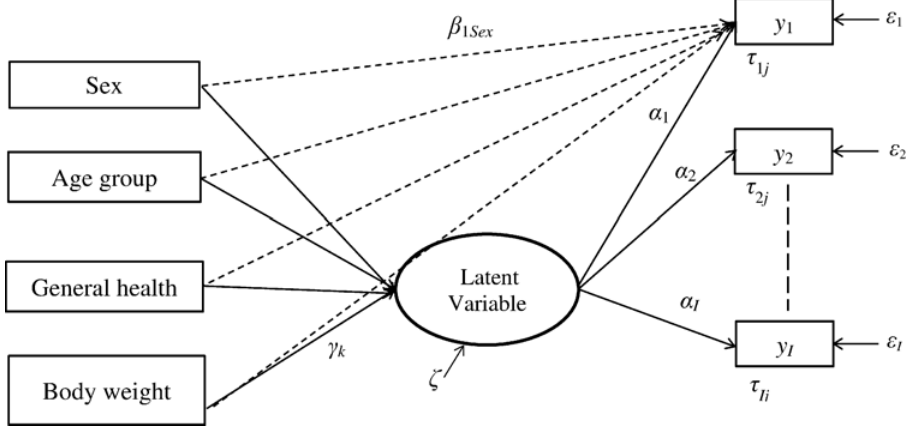
Fig 1. Illustration of the multiple indicators multiple causes model to test for differential item functioning on SF-36 sub-scale items. In this model, y i is the i th sub-scale item ( i = 1, ... , I ); the dashed arrow from each covariate to the item represents the DIF (i.e., direct) effect; β 1Sex is the regression coefficient for the difference in thresholds on item i for males and females; similar regression coefficients are defined for other model covariates; α i is the regression coefficient for the latent variable and the i th item; γ k is the regression coefficient for the latent variable and the k th covariate ( k = 1, ... , K ); τ ij is the threshold for the ( j – 1) th response category (j = 1, ... , J ) for item i ; ε i is the error term for the i th item; ζ is the residual error for the latent